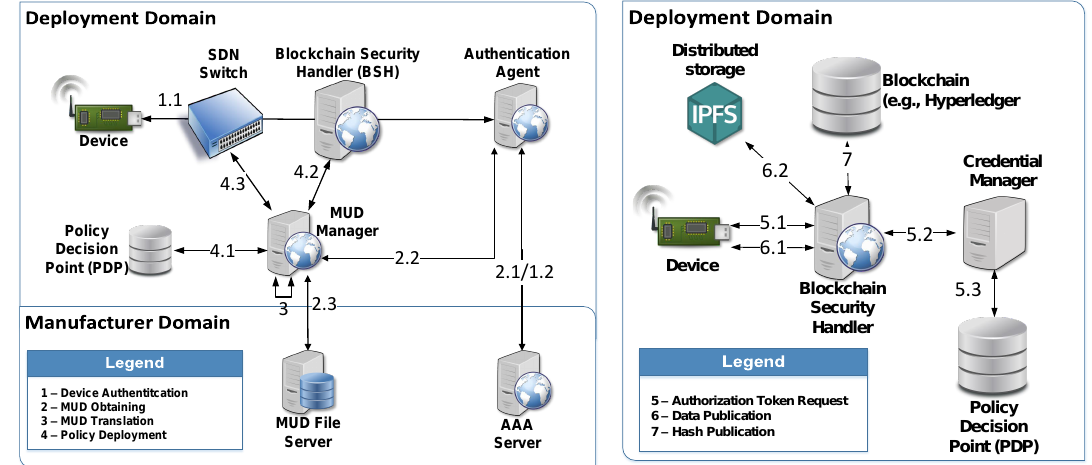
Figure 1. Proposed